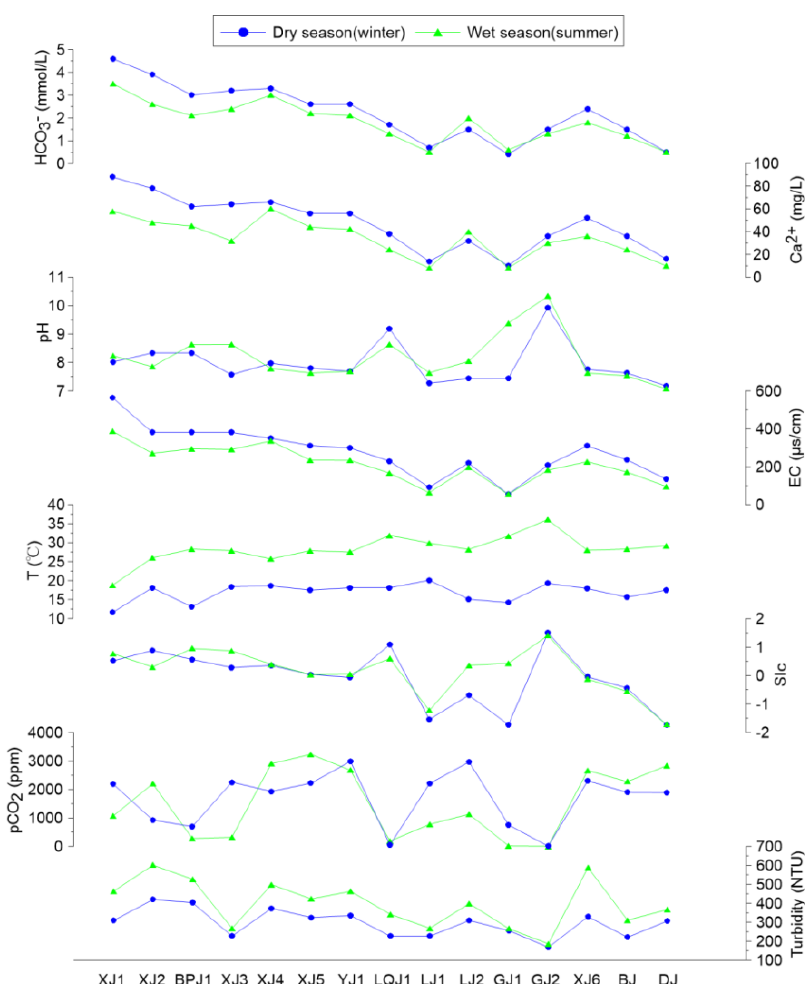
Figure 2. Geochemical parameters of water samples in the Pearl River basin. The pCO 2 value ranged from 4.1 ppm to 2985.0 ppm (average 1684.0 ± 928.1 ppm) in the winter and 0.4 ppm to 3235.9 ppm (average 1503.9 ± 1170.2 ppm) in the summer. The SIc value ranged from −1.73 to 1.52 (average −0.07 ± 0.97) in the winter and −1.72 to 1.41 (average 0.17 ± 0.08) in the